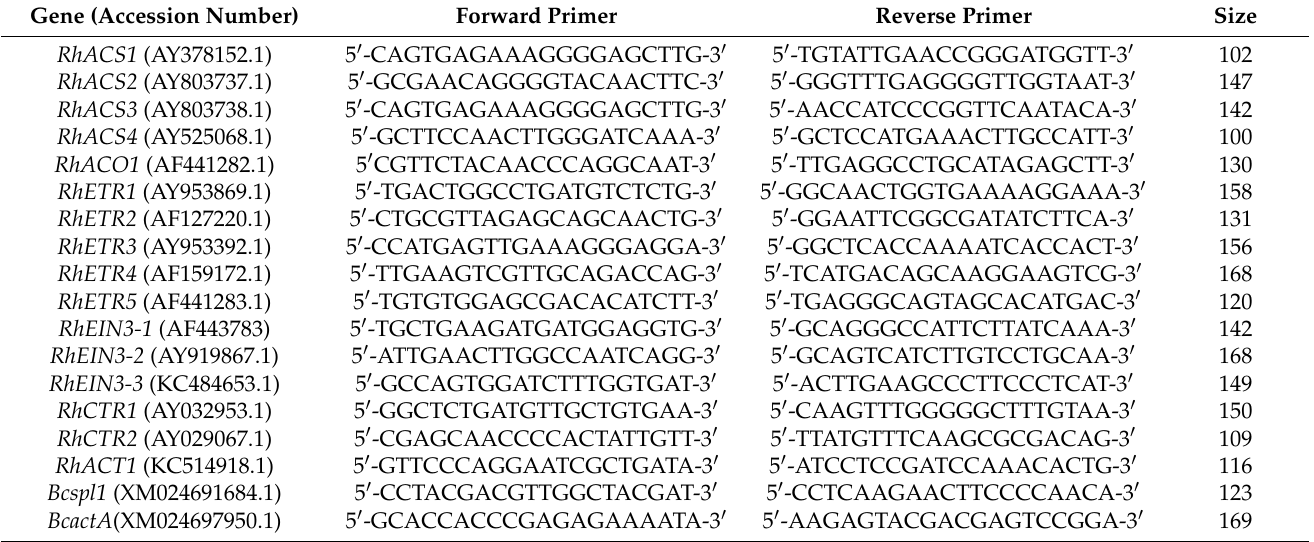
Table 2. Primer sequences used in qRT-PCR for gene analysis in rose